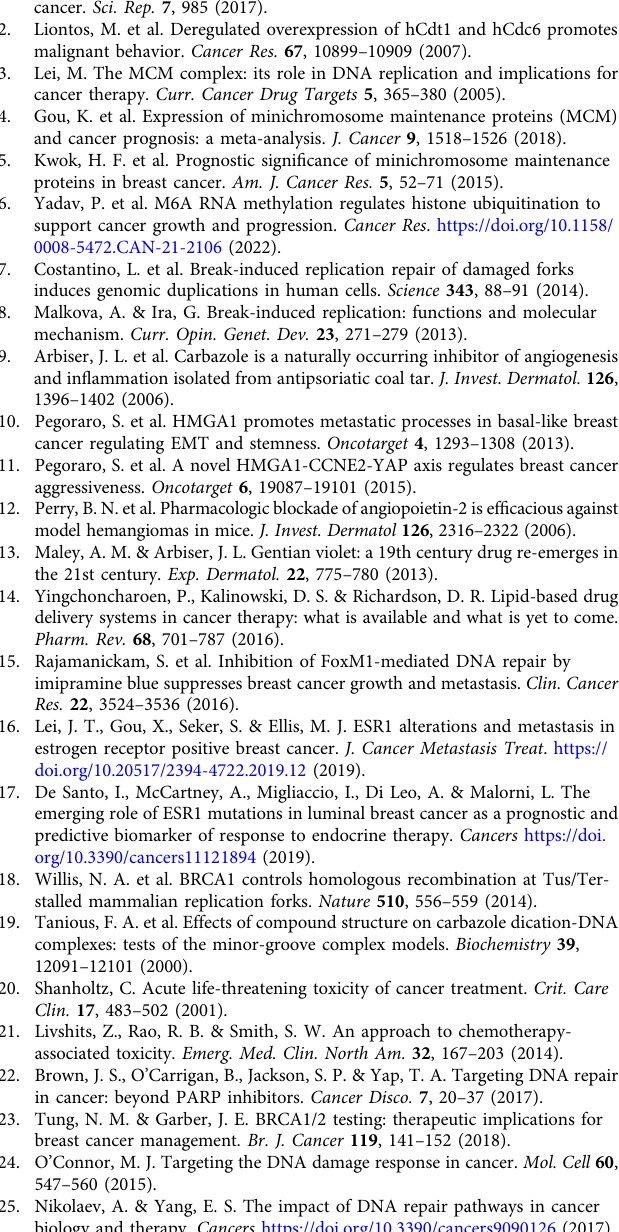
Fig. 8 CB is a safer DNA-binding compound. a Immuno fl uorescence analysis using antibodies against 53BP1 and γ -H2AX (green) on vehicle control or CB- treated MDA-MB-231 cells shows co-localization of 53BP1 and γ -H2AX foci. Scale bar, (100X, 1 µ m). b Flow cytometry analysis showing levels of GFP- positive cells re fl ecting NHEJ events in cells treated with vehicle or CB. EJ5-GFP integrated U2OS cells were treated with vehicle or CB (1 µ M) for 12 h, followed by infection with a pCAGGS vector with I-SceI/GFP. GFP + cells re fl ecting NHEJ events were determined by fl ow cytometry after 72 h. The experiment was performed in triplicate along with appropriate control. c Fluorescence polarization-based assay showing CB ’ s ability to bind to double- stranded DNA. d Top, schematic illustration of chromatin immunoprecipitation (ChIP) primers fl anking the HMGA1 binding site in the promoter region of the human cyclin E2 gene. Bottom, ChIP-qPCR showing fold change in the recruitment of HMGA1 to the cyclin E2 promoter in vehicle or CB (1 µ M)-treated MDA-MB-231 cells. e Survival rate of mice treated with vehicle, CB (3 mg/kg body weight), or DOX (2.5 mg/kg body weight) conjugated with intralipid every 5 days ( n = 6). f Mean tumor volume in vehicle- and CB conjugated with intralipd + doxorubicin (Dox)-treated mice. MDA-MB-231 cells were subcutaneously implanted into mammary fat pads of athymic nude mice. After tumors reached approximately 100 – 150 mm 3 , mice were treated with vehicle, CB (1.5 mg/kg bw), DOX (1 mg/kg bw) conjugated with intralipid and CB (1.5 mg/kg bw)-intralipid + DOX (1 mg/kg bw) combination every 5